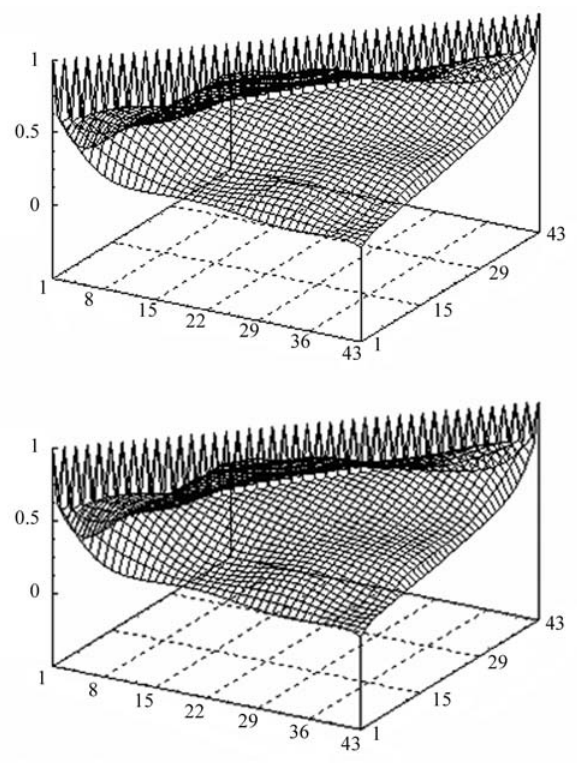
Figure 4 - Estimates of phenotypic correlations between TDMY obtained with 4,6,vf6 (above) and 6,6,vf6 (bellow) random regression models.